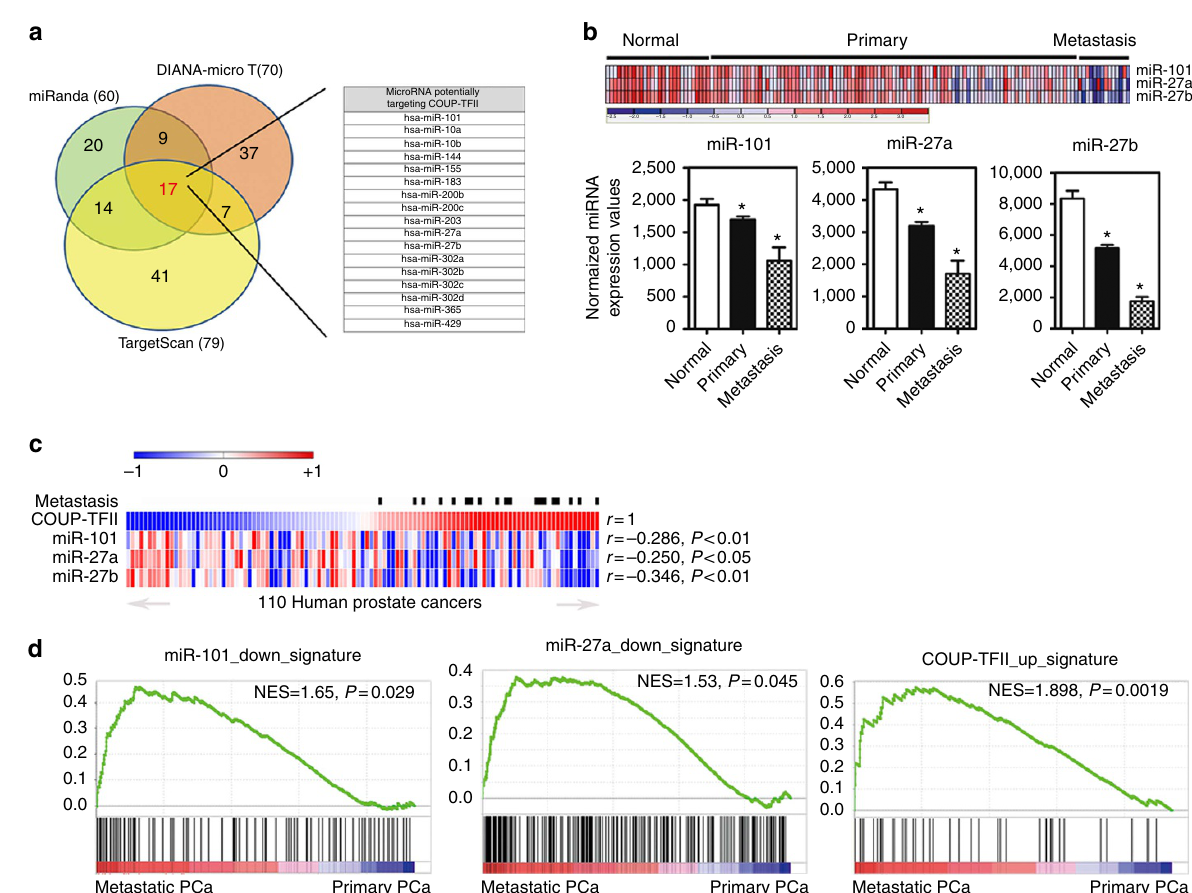
Figure 1 | miR-101 and miR-27a loss which correlates with COUP-TFII de-repression promotes metastasis. ( a ) COUP-TFII 3 0 -UTR region was used for analysis of miRNA-binding sites by using three different bioinformatic tools. ( b ) Heatmap and quantified results show the levels of miR-101, miR-27a and miR-27b in the clinical PCa data set of Taylor. Normal ( n ¼ 28); primary PCa ( n ¼ 99); metastatic PCa ( n ¼ 14). * P o 0.05 (two-sided Student’s t -test) compared with the normal prostate group. ( c ) Heatmap shows negative correlation between COUP-TFII and miR-101, miR-27a and miR-27b expressions in clinical PCa including primary and metastatic PCa specimens analysed from the Taylor data set. Correlation values were calculated by Pearson’s correlation test. ( d ) miR-101-downregulated (GSE13674), miR-27a-downregulated (GSE65874) and COUP-TFII-upregulated (GSE33182) gene signatures were analysed by GSEA in the gene sets (GSE32269) derived from metastatic and primary patients. FDR ¼ 0.09 (miR-101); FDR ¼ 0.16 (miR-27a); and FDR ¼ 0.02